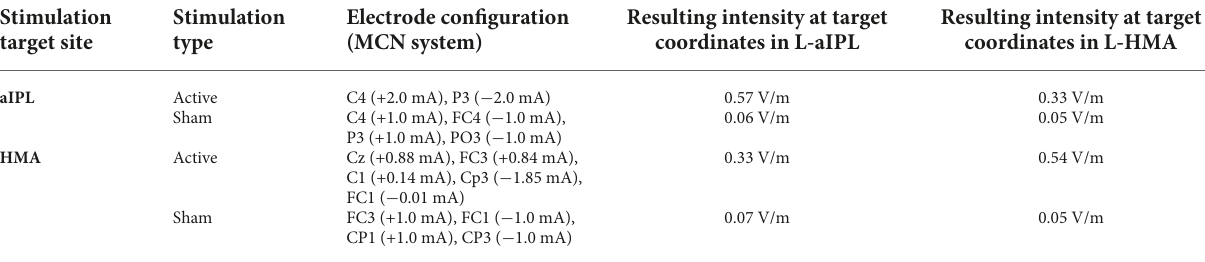
TABLE 3 Electrode configurations. Stimulation target